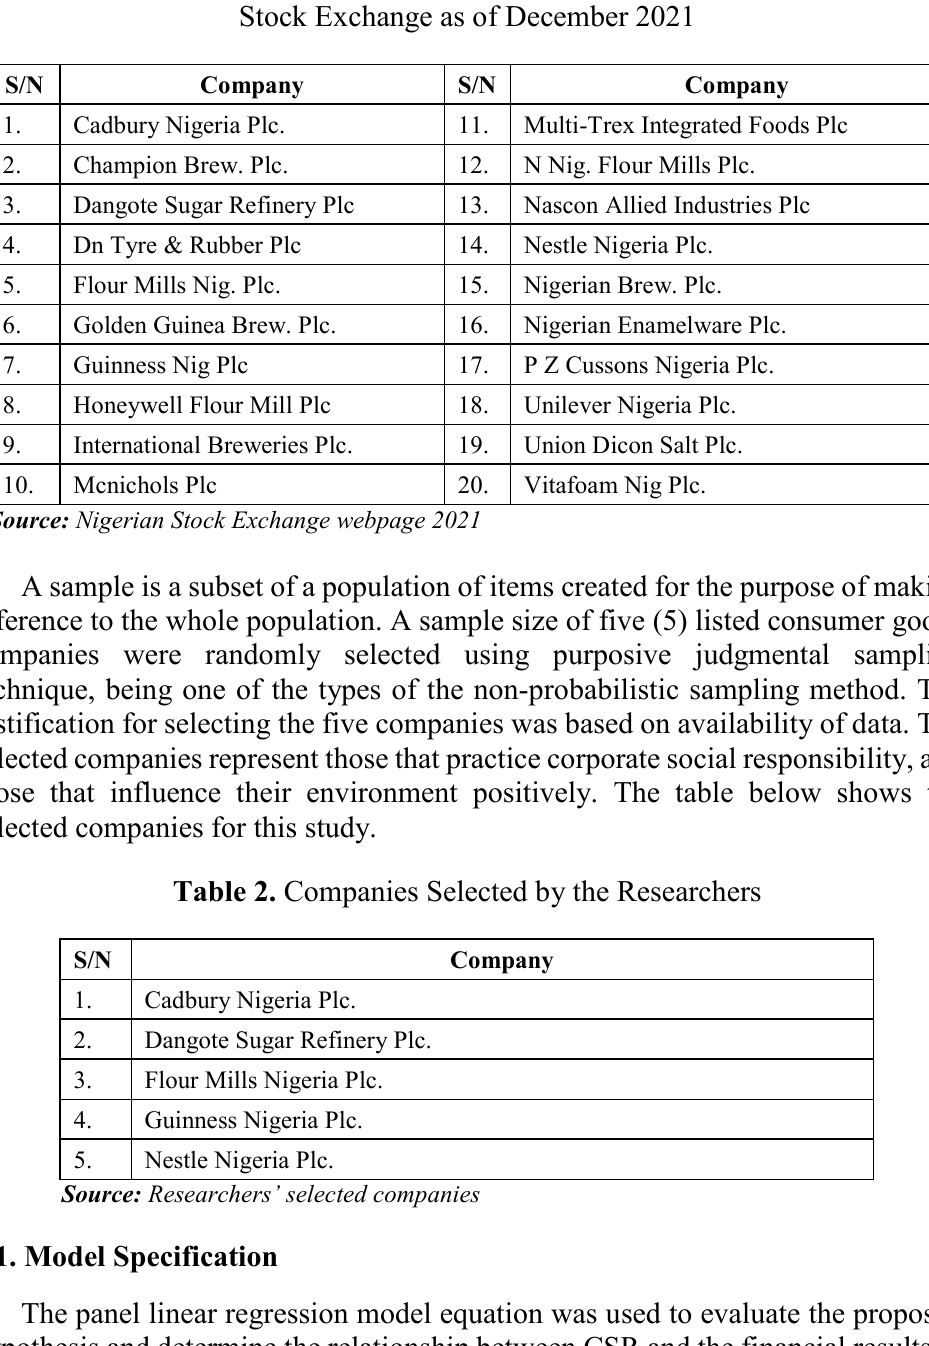
Table 1. List of Consumer Goods Manufacturing Companies Listed in the